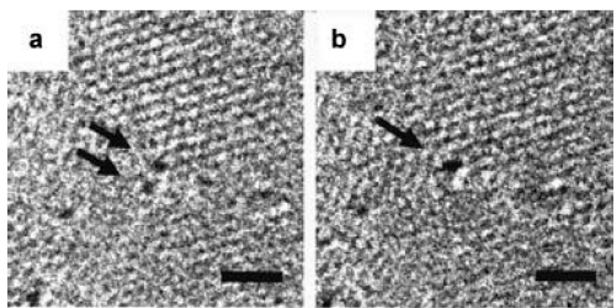
Figure 18. ( a , b ) Plan-view Transmission Electron Microscopy images of Pt atoms in a four-layer graphitic sheet held at 600 °C. The image ( b ) was acquired 60 s after ( a ). Two Pt atoms (arrowed) merge and form a cluster. The scale bar is 1 nm. Reproduced from Reference [58] with permission from